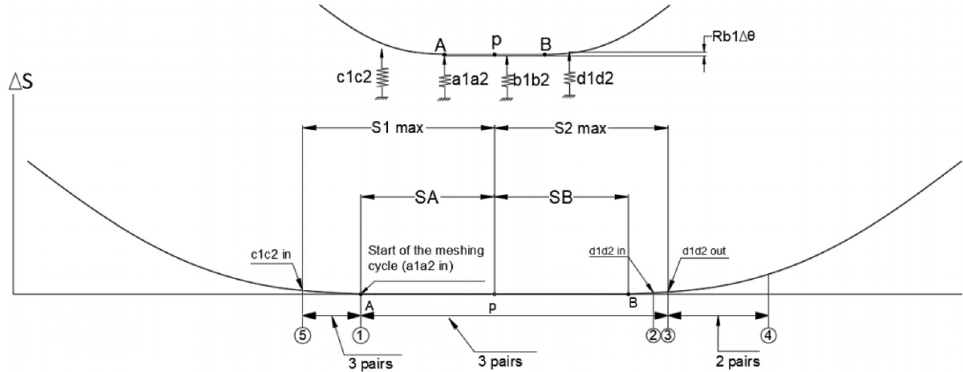
Fig. 13. Behavior the 40/40 plastic/steel gear gear for an applied torque of 500 Nm.